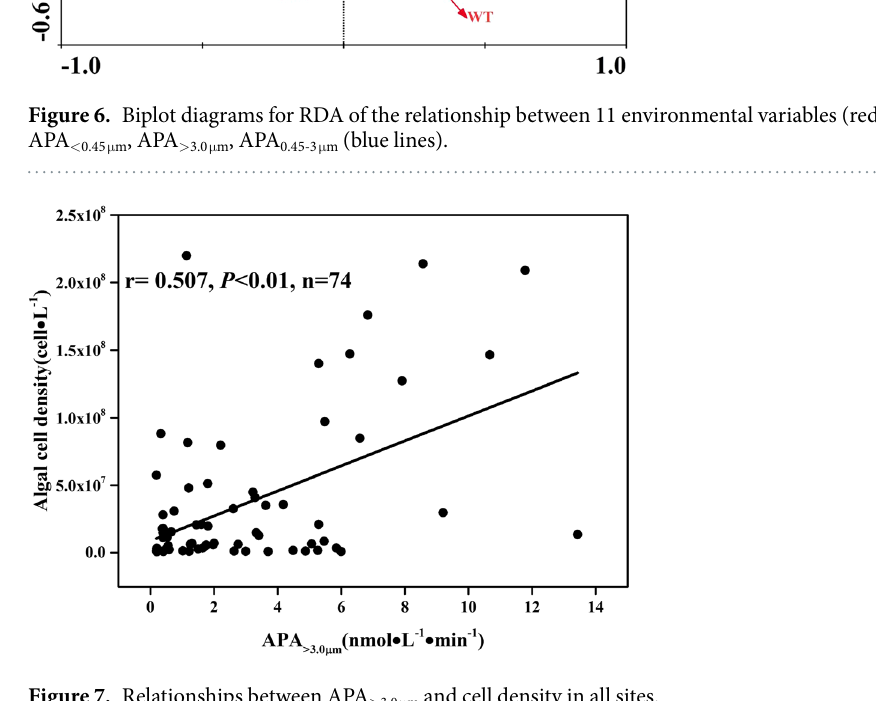
Figure 7. Relationships between APA > 3.0 μ m and cell density in all